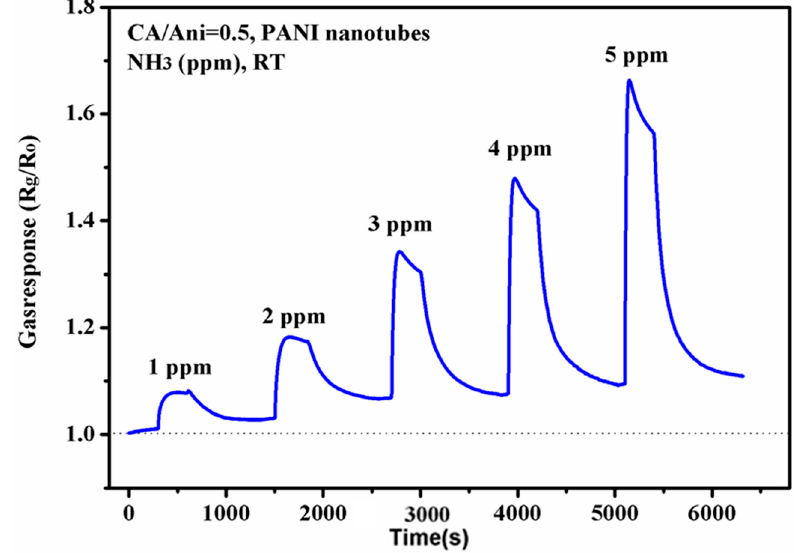
Figure 9. Gas sensing response of the nanotubes sensor to ammonia ranging from 1 to 5 ppm at room temperature.